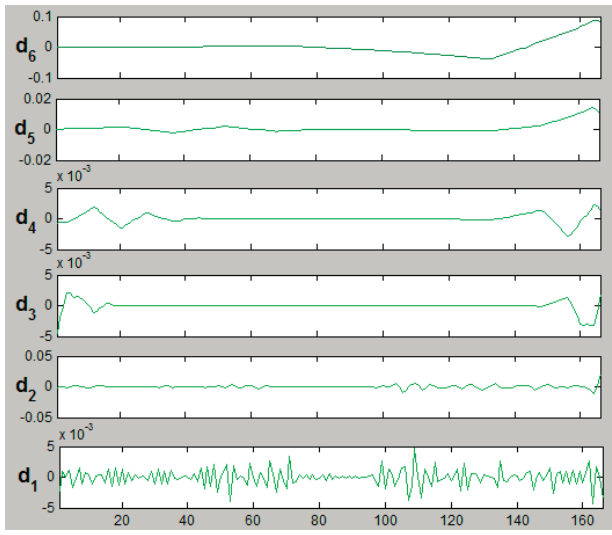
Figure 17. Details of d1–d6 of reconstructed signal X_AT_kE3_6sym3_a6d12.